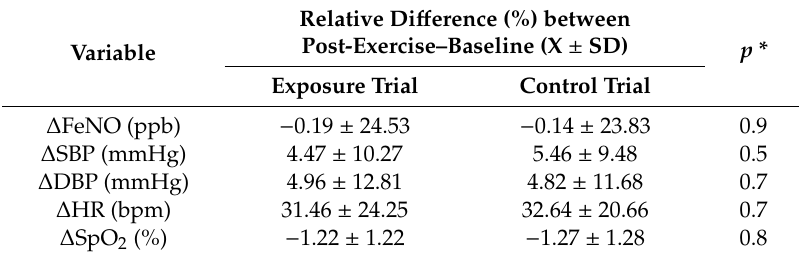
Table 4. Relative di ff erences between baseline and post-exercise measurements. Relative Di ff erence (%) Variable